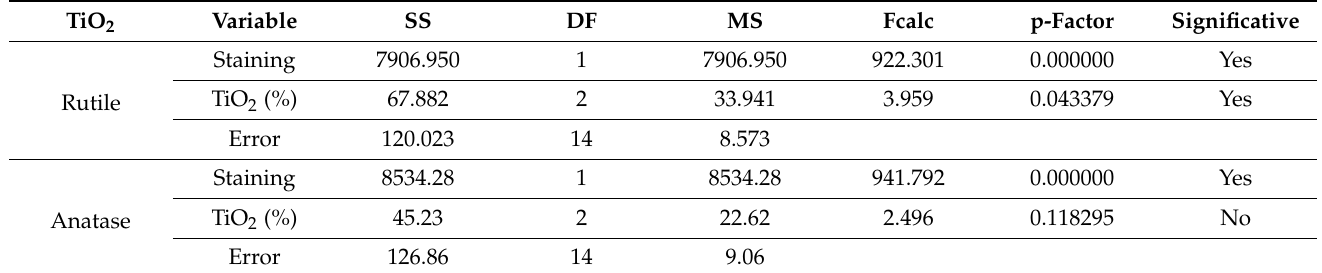
Table 5. Main effects analysis of variance for tiles produced with TiO 2 rutile and anatase, with and without staining by rhodamine B, cured in an urban environment over time.